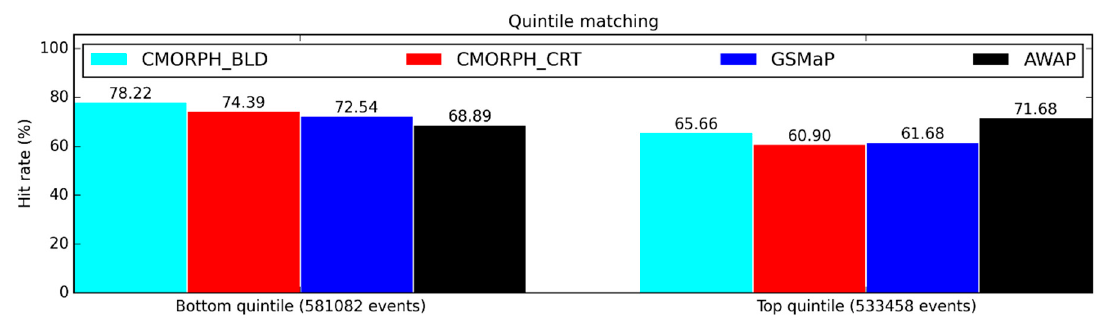
Figure 12. Gridded comparison of satellite datasets and AWAP against ERA5 reanalysis from January 2001 to December 2018. Quintile comparison is displayed.